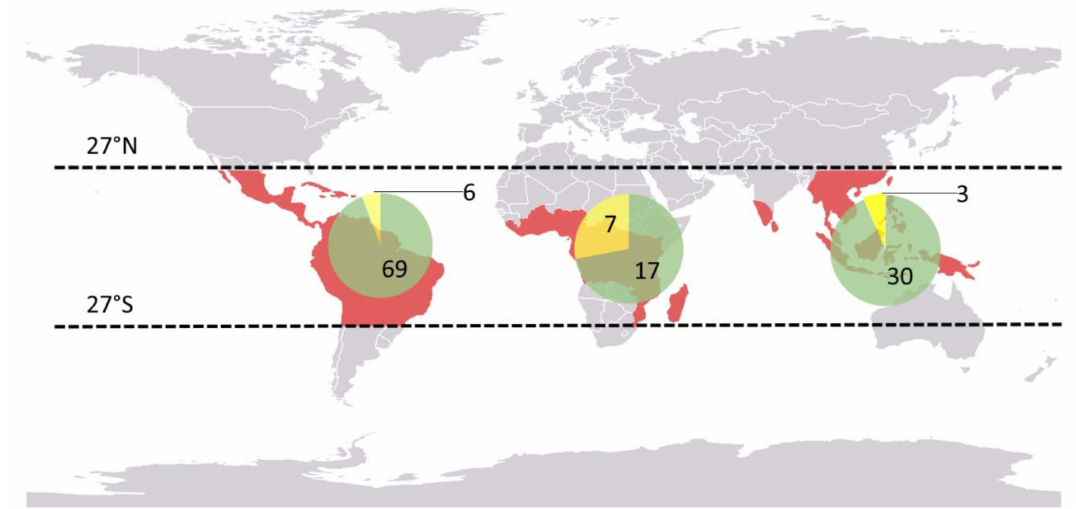
Figure 2. World distribution of Vanilla species: number of leafy Vanilla species (in green) and number of leafless species (in yellow) based on the World checklist of Selected Plant Families [27], the International Plant Name Index [28] and the database of Tropicos